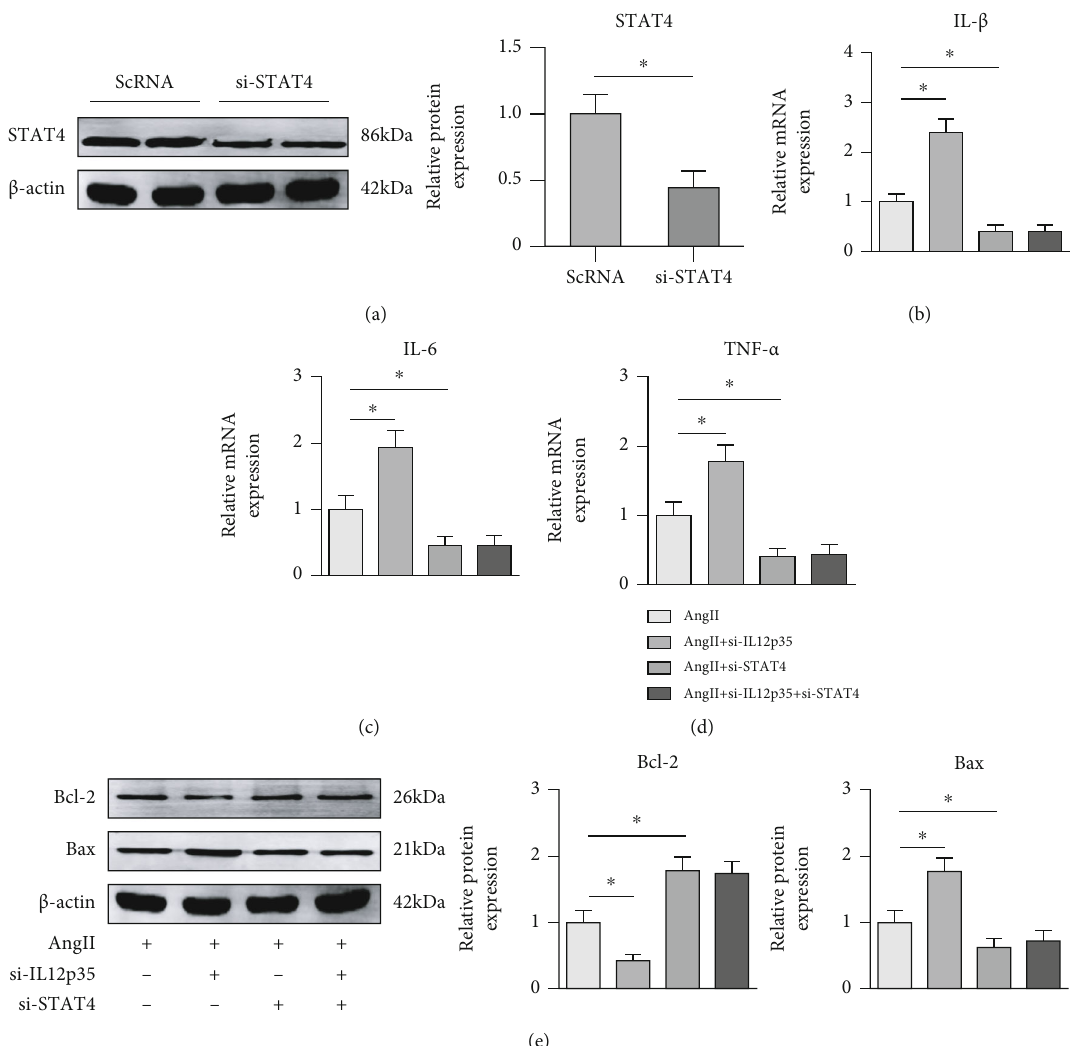
Figure 7: STAT4 silencing abolishes IL12p35-mediated in fl ammatory responses and SMC apoptosis. (a) Western blot analysis of STAT4 expression after transfection with si-STAT4 ( n = 4 per group). (b – d) PCR analysis of IL-1 β , IL-6, and TNF- α mRNA expression in the four groups ( n = 6 per group). (e) Western blot analysis of the protein levels of Bcl-2 and Bax in the four groups ( n = 4 per group). ∗ P < 0 : 05 compared with the Ang II